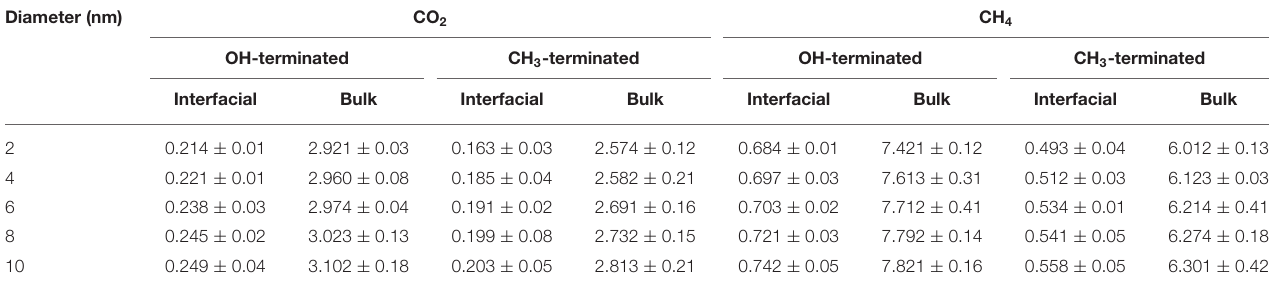
TABLE 2 | Self-diffusion coefficients (10 − 4 cm − 2 /sec) of interfacial and confined free gas molecules (bulk) in OH-terminated and CH 3 -terminated pores as a function of the pore diameter. Diameter (nm) CO 2